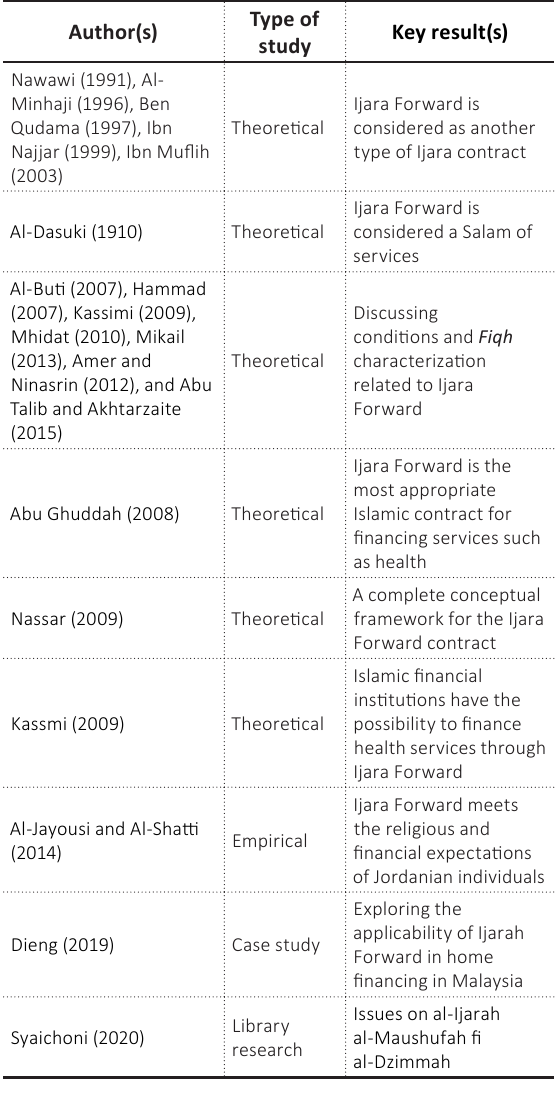
Table 1. Summary of the literature